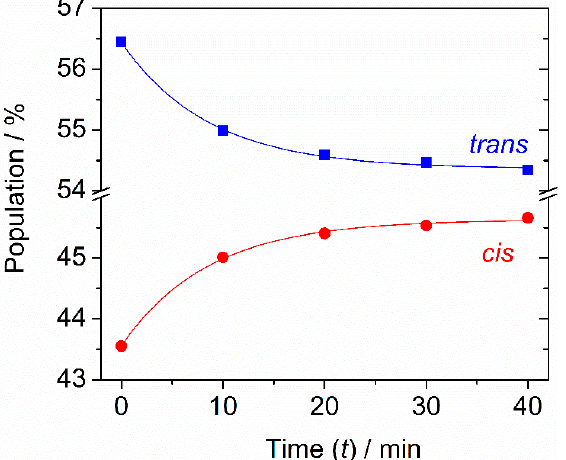
Figure 4. Time evolution of the population of the two conformers of m FP isolated in N 2 at 14 K after removing the long-pass filter cutting the IR light above 2200 cm − 1 emitted from the spectrometer and letting the sample be exposed to the unfiltered radiation. The populations of the conformers were estimated by integration of experimental IR intensity for the pair of bands observed at 1140 and 1129 cm − 1 , assigned, respectively, to the cis and trans conformers. Blue and red lines correspond to the fits of experimental data using the equation: y = a + b × exp [ − ( k t → c + k c → t ) t ], describing the first-order reversible reaction. Fitting results: a = 54.36 ± 0.04 (blue squares) or a = 45.64 ± 0.04 (red circles); b = 2.08 ± 0.06 (blue squares) or b = − 2.08 ± 0.06 (red circles); k t → c + k c → t = 0.12 ± 0.01; R 2 = 0.997. On the other hand, k c → t / k t → c = 54.36/45.64.